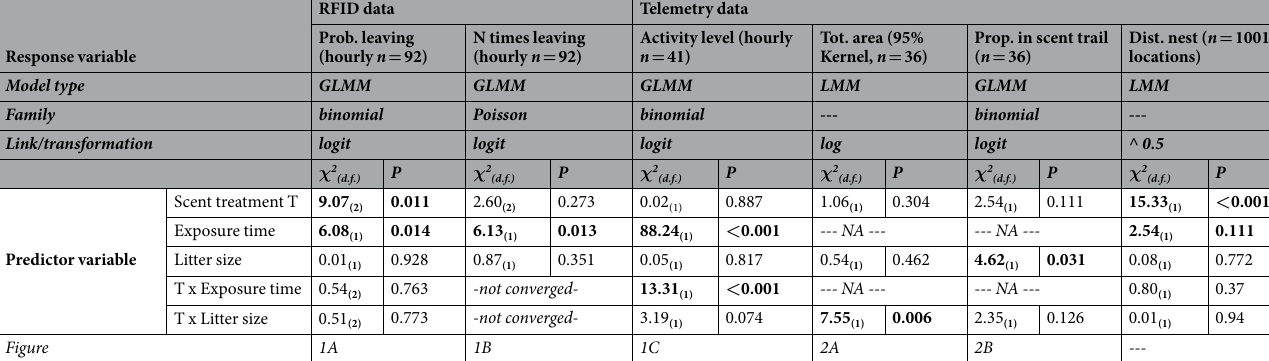
Table 1. Effects of scent treatment (stranger/sire, plus control for RFID data), exposure time, litter size, and interactions on behavioural responses of 35 lactating, non-pregnant bank vole females. The hourly probability of leaving the nest, number of times leaving, and activity level, and the total area visited during the 5-hour monitoring period (log transformed to meet assumption of normality), proportion of locations within the scent trail, and distanced from the nest (square root transformed for normality), were modelled using (generalized) linear mixed models ((G)LMM). Significant effects (alpha level 0.05) are depicted in